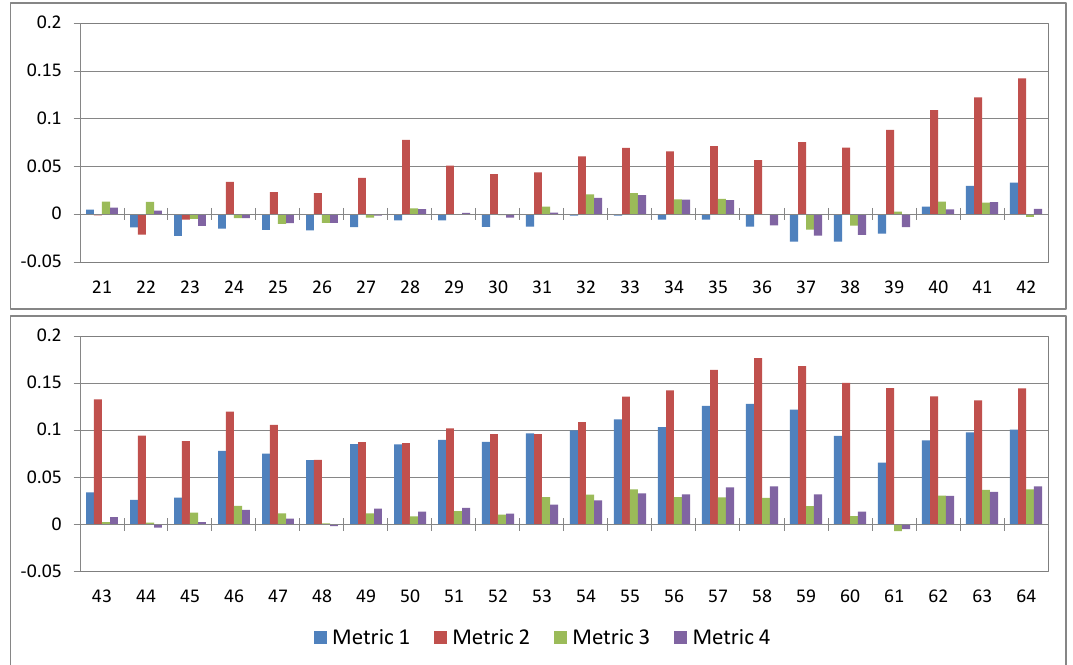
Figure 7. Anomalies of moving-average normalized IP metrics calculated using an averaging window of 20 TCs. These results were obtained from Figure 6 by performing the following two operations: (1) computing the twenty-TC moving average of the normalized metrics and (2) subtracting the average normalized metrics for TC No. 20 (which gives the mean of the normalized metrics of the first 20 landfalling TCs of the 21st century) from the others (which explains why the x-axis starts at TC No. 21). Positive values indicate an increase in IP compared to the first 20 TCs in the WRF simulations whereas negative values indicate a decrease in IP compared to the first 20 TCs in the WRF